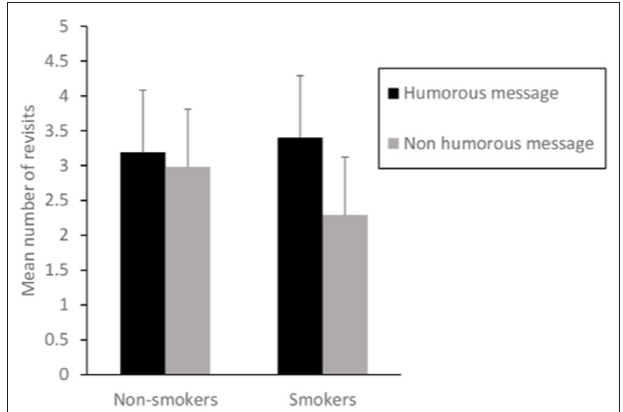
FIGURE 1 | Interaction effect between type of ads and individuals’ involvement. Standard errors are represented by the error bars attached to each